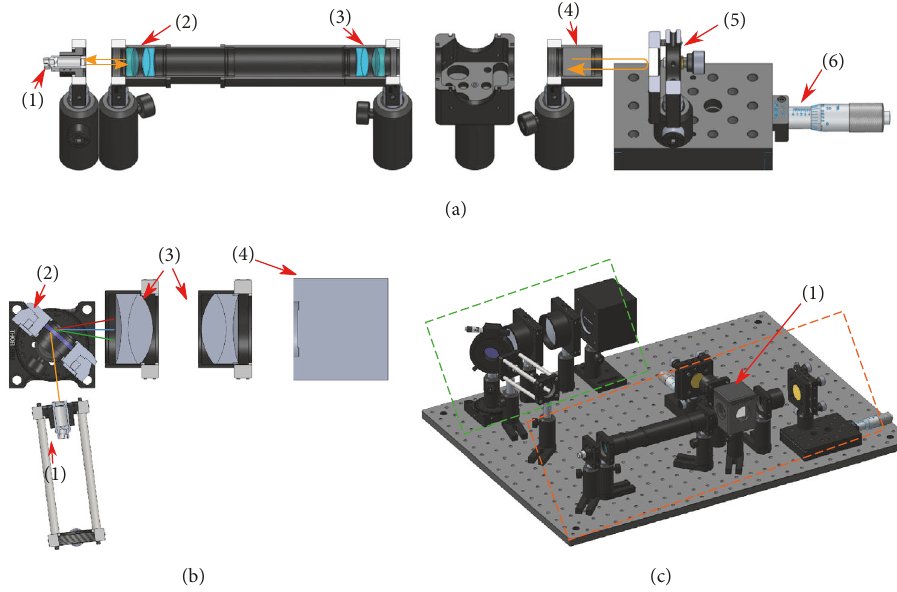
Figure 5: SOLIDWORKS design of the reference and spectrometer arms. (a) The CAD design of the reference arm. (1) Fiber connector, (2) scan lens, (3) tube lens, (4) dispersion compensator for the objective, (5) a gold mirror installed on a kinematic mount with adjustable angles, and (6) translational stage to precisely control the position of the reference mirror. (b) The CAD design of the spectrometer arm. The grating has an optimal incident angle of 48.6 ∘ and diffraction angle of 48.6 ∘ . It is mounted on rotatory mounts to adjust the angles of the grating with respect to the OCT beam and the lens mechanism. (1) Fiber connection, (2) grating installed on rotatory mounts, (3) Pl¨ossl lens, and (4) line CCD camera. (c) The reference and spectrometer arms are installed on an optical breadboard to facilitate transportation. There is a movable mirror mount, component (1) , in the reference arm that can change the beam path to match different objective lenses in the sample arm. The reference and spectrometer arms are encircled with orange and green rectangles,